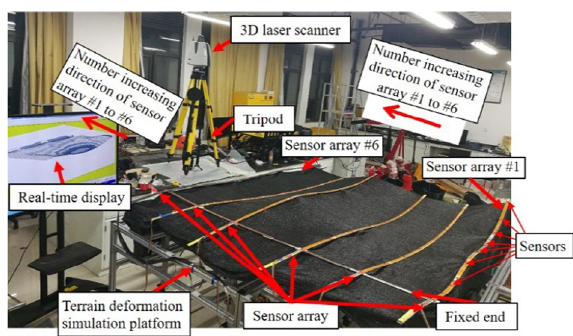
Fig. 10 Shape #1 of simulation